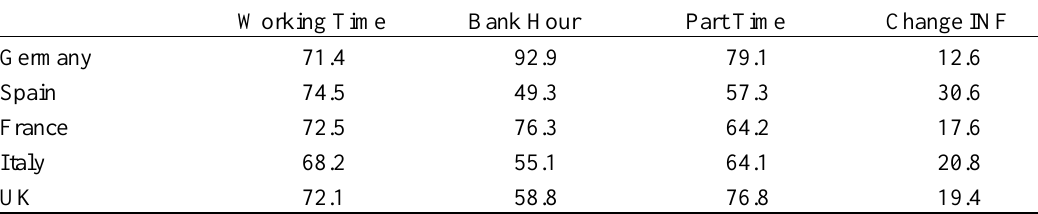
Table 3 . Internal Numerical Flexibility by type, country, and change since 2010 (% of establishment) Working